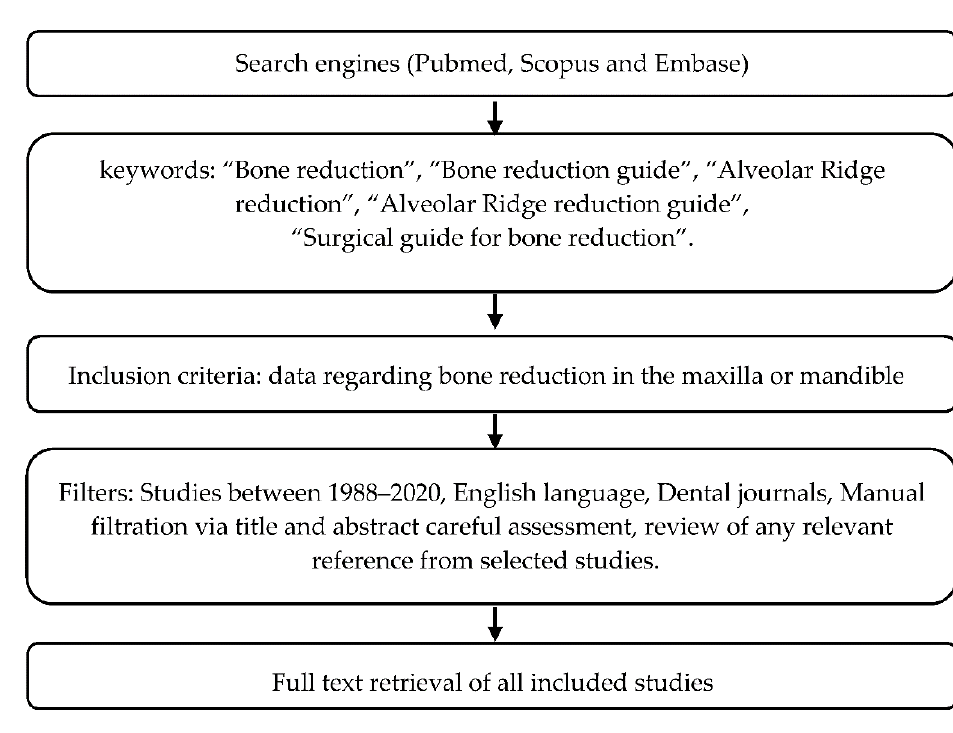
Figure 1. Flowchart depicting the selection process for included